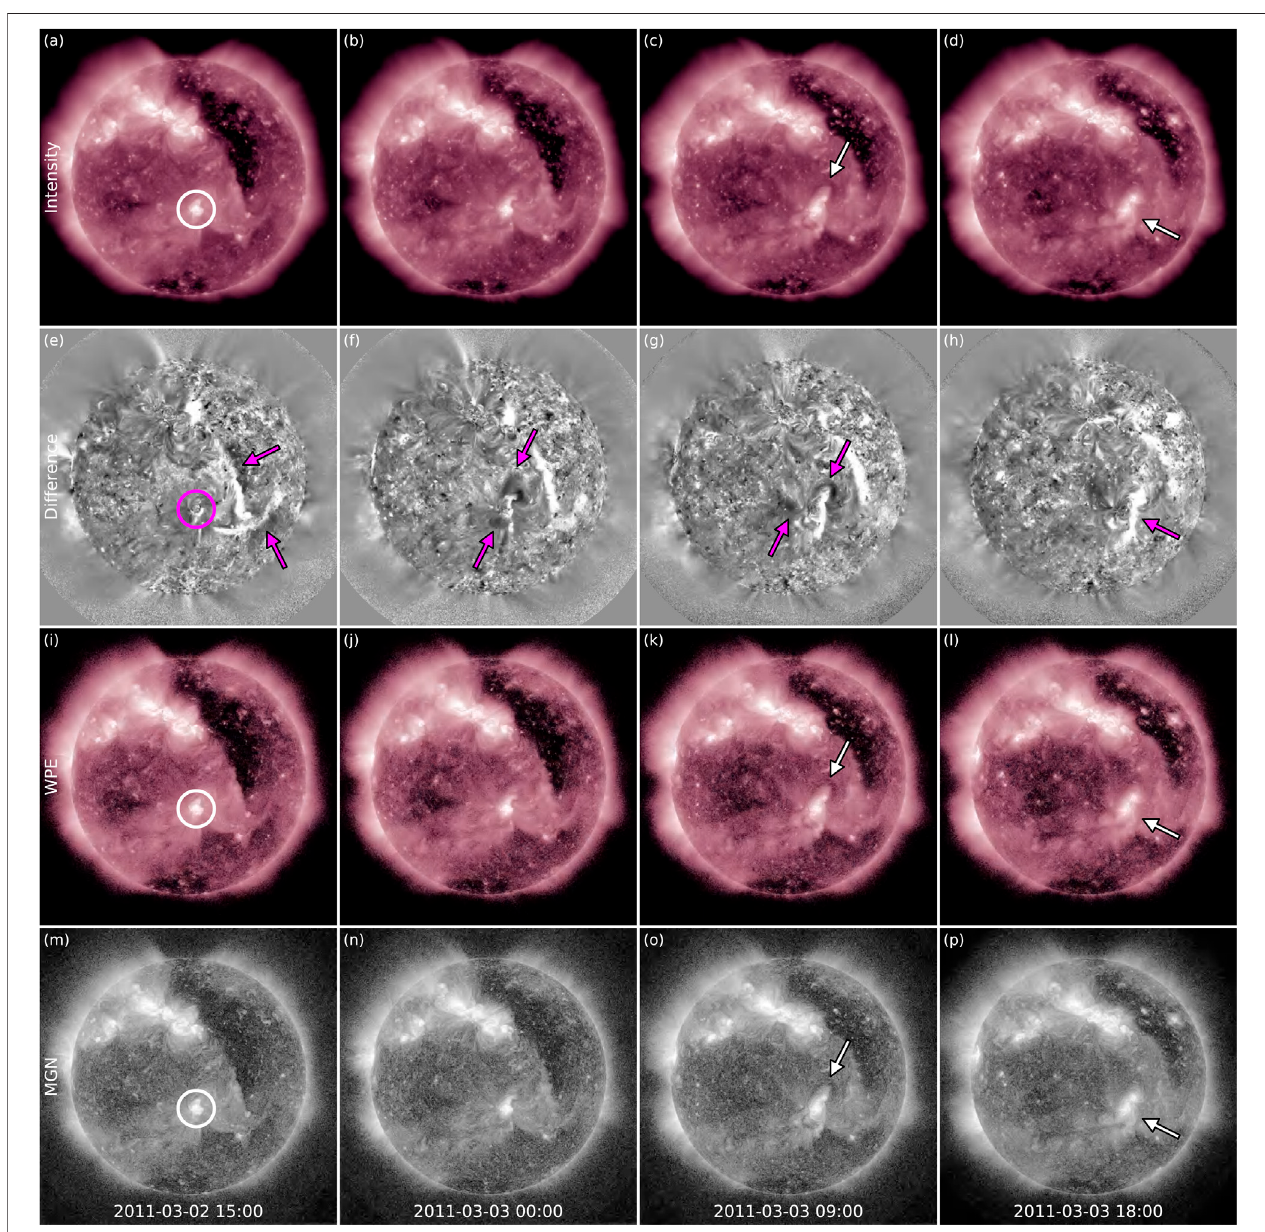
FIGURE 3 | Imaging techniques applied to the 2011 March 3 CME (Event 2). SDO/AIA 211Å images are shown at four different times and processed with four different methods. (A – D) Intensity images. (E – H) Difference images with fi xed Δ t (cid:2) 12 h. (I – L) WPE-processed images. (M – P) MGN-processed images. AR 11165 is circled in the fi rst column. Dimming and brightening regions are indicated with arrows (see text for